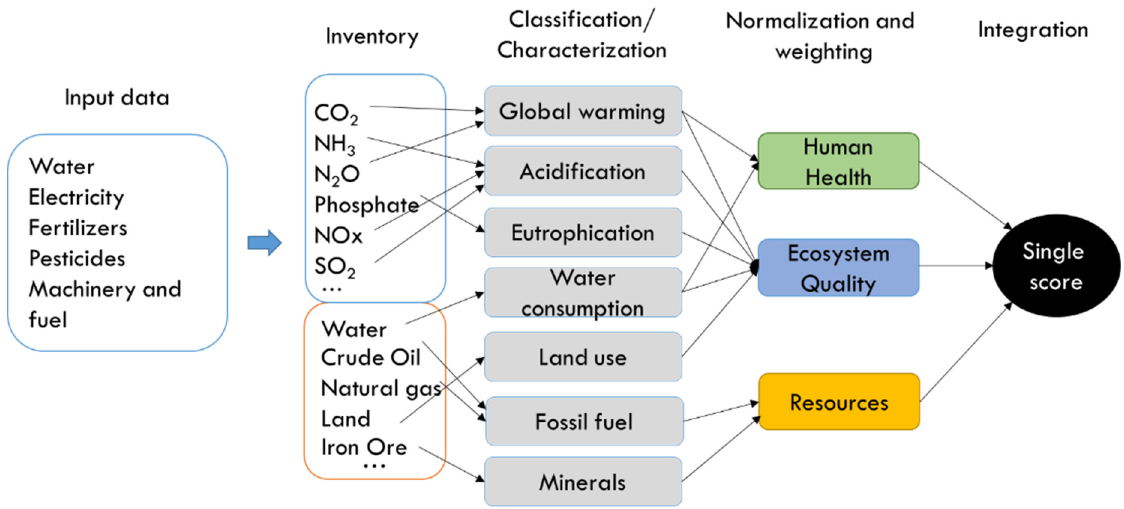
Figure 4. ReCiPe 2016 impact pathway from inventory to aggregation to a single score.